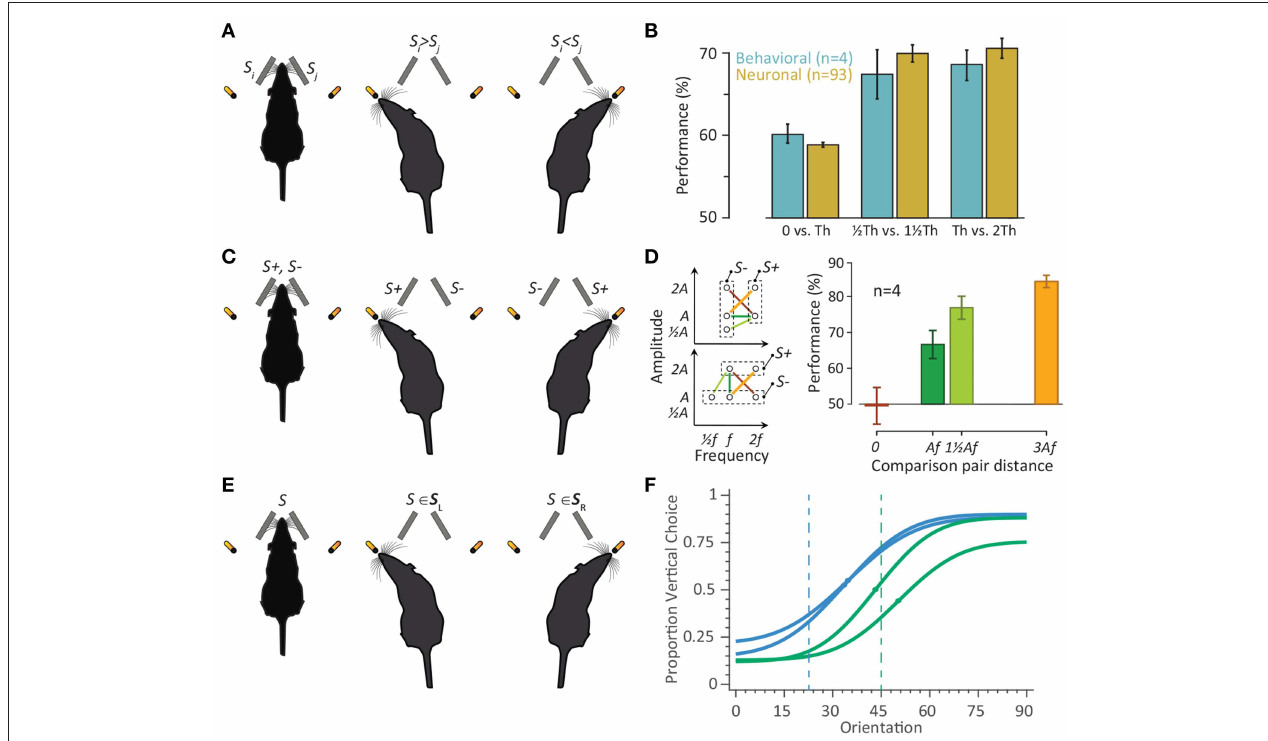
FIGURE 4 | The two-alternative-choice behavioral tasks in rodents. (A) Schematic representation of the comparative discrimination paradigm. On every trial, two vibrations S i and S j were presented. (B) Four rats were trained in the detection/discrimination task to identify the vibration with the higher amplitude. The neuronal performance is the average performance (based on the area under ROC) across single-units ( n = 35) and multiunit clusters ( n = 58) from Adibi and Arabzadeh (2011). For each neuron, the stimulus intensity whose detection performance was closest to 60% was chosen as detection threshold ( Th ). The stimuli corresponding to 1 2 − , 1 1 2 − , and 2-fold Th were then selected for estimating the discrimination performances. The same threshold of 60% defined as detection threshold for rats. The rats performed the comparison task between 0 − Th , 1 2 − 1 1 2 and Th − 2 Th . Error bars indicate standard error of means across rats or neurons. (C) Schematic representation of the categorical discrimination paradigm. Stimuli were defined as either S + or S − . In each trial, one of the two vibrations was S + and the other was S − . Having identified the S+ vibration, the rodent expressed its choice by turning toward the corresponding drinking spout. (D) (Left) Stimulus space. Each circle represents the frequency–amplitude combination of one stimulus. Two groups of rats were trained in the task. For one group (top-left), two frequencies ( f = 80 Hz and 2 f = 160 Hz) and three amplitudes ( 1 2 A = 8 µ m, A = 16 µ m, and 2 A = 32 µ m) were used to generate five vibrations, and for second group (bottom-left) three frequencies ( 1 2 f = 40 Hz, f = 80 Hz and 2 f = 160 Hz) and two amplitudes ( A = 16 µ m and 2 A = 32 µ m) were used to generate five vibrations. Stimuli that were presented together and had to be discriminated (paired stimuli) are connected by lines. The right panel shows the proportion of correct trials (performance) for the corresponding four stimulus-pairs averaged across rats. Error bars are s.e.m. across rats. Re-plotted from (Adibi et al., 2012). (E) The schematic representation of the categorization paradigm. The stimuli are divided into two categories of S L and S R , corresponding to left and right choices, respectively. A stimulus S was presented on every trial. The rat identifies the category which stimulus S belongs to. (F) Rats were trained to categorize the orientation of a 9.8 cm-diameter disc with alternating ridges and grooves by licking at one of the two reward spouts. Psychometric functions correspond to two rats trained to categorize orientations 0–45 ◦ as horizontal, and 45–90 ◦ as vertical (green), and another two rats trained to categorize orientations 0–22.5 ◦ as horizontal, and 22.5–90 ◦ as vertical (blue). The curves correspond to a Gaussian cumulative function fitted to data. The dots on each curve represent the perceptual decision boundary of each rat. The blue and green vertical dashed lines represent the categorization boundaries of 22.5 ◦ and 45 ◦ ,